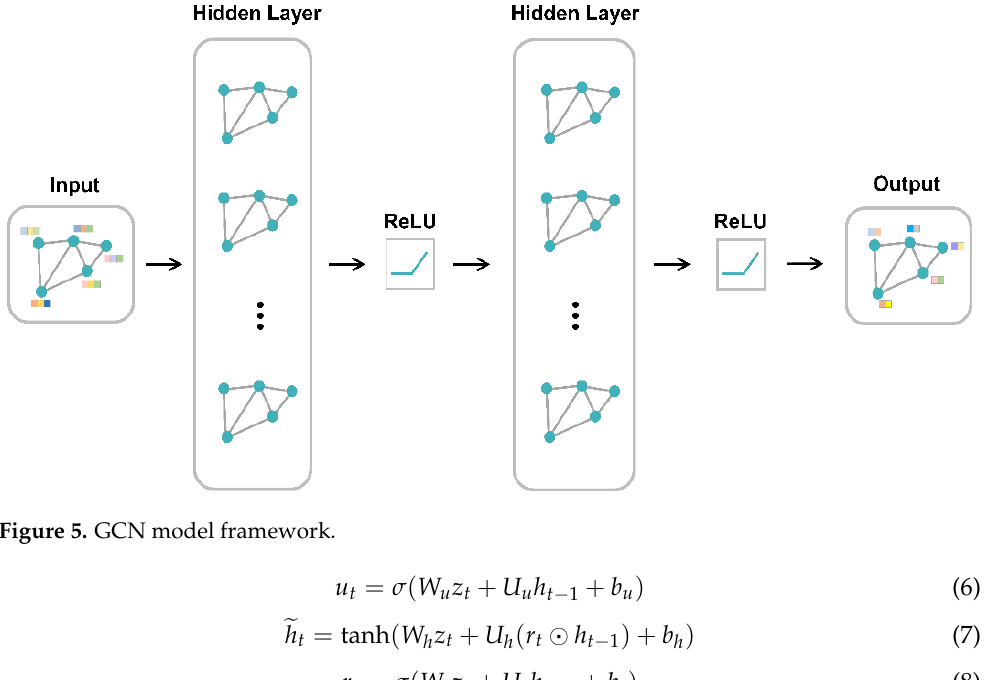
Figure 5. GCN model framework.